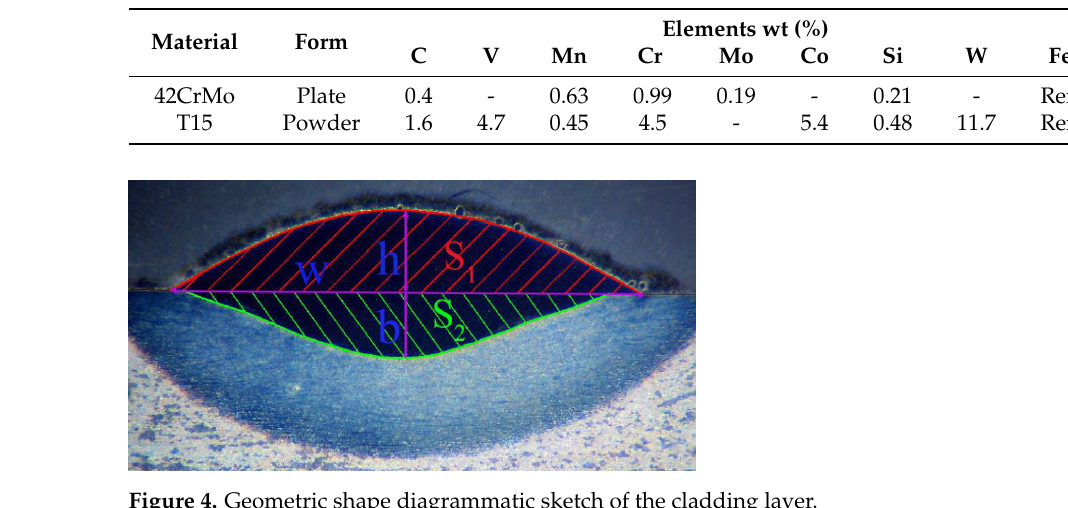
Table 1. Chemical composition of clad powder and substrate materials.